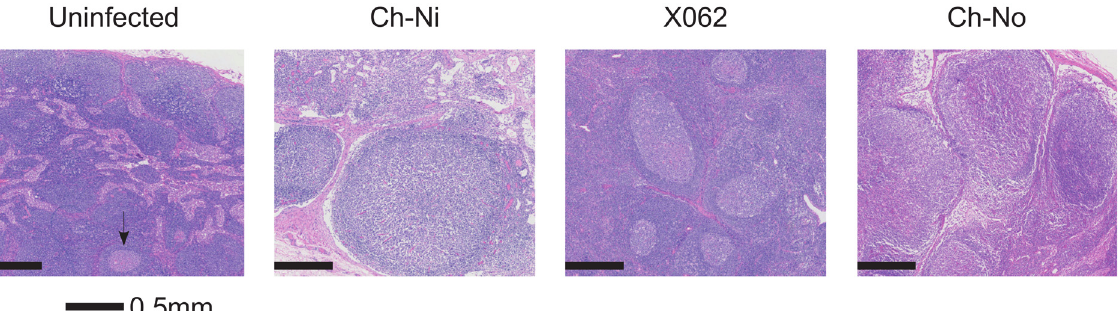
Fig 4. Lymphoid hyperplasia in SIVcpz infected chimpanzees. Representative images from one uninfected chimpanzee, and the three available lymph node samples from chronic SIVcpz infected chimpanzees (detailed in Table 2). Arrow indicates the one normal follicle visible in the image from the uninfected